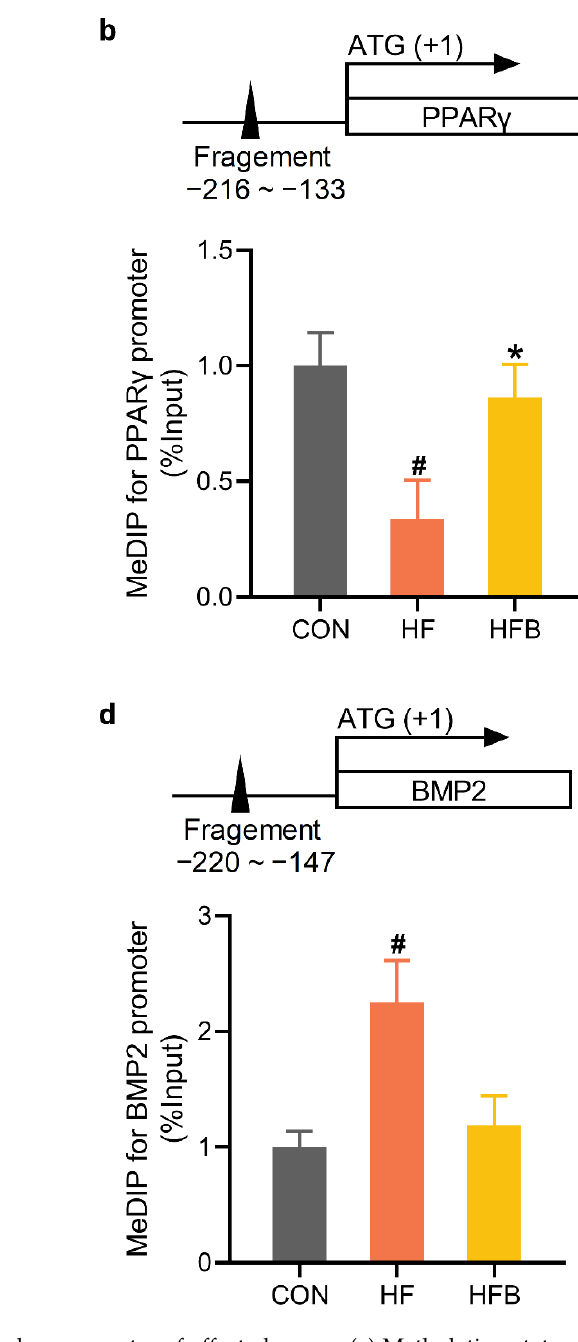
Figure 5. Hepatic methylation level on promoter of affected genes. ( a ) Methylation status on the promoter of CD36 gene ( n = 3). ( b ) Methylation status on the promoter of PPAR γ gene ( n = 3). ( c ) Methylation status on the promoter of HAMP gene ( n = 3). ( d ) Methylation status on the promoter of BMP2 gene ( n = 3). Values are means ± SEM. # p < 0.05 and ## p < 0.01 compared with the CON